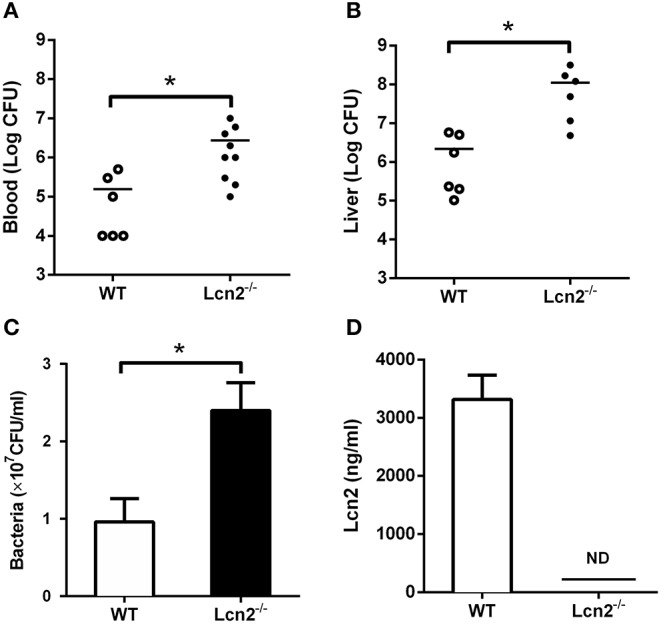
The bacteriostatic characteristics of lipocalin 2 (Lcn2). (A,B) Bacterial loads in blood (CFU/ml) and livers (CFU/mg) of E. coli O157:H7-infected mice 32 hpi. (C,D) Serum levels of Lcn2 protein measured and growth of E. coli O157:H7 in RPMI with 20% acute-phase serum from wild-type (WT) or Lcn2−/− mice. Values are average means of triplicate experiments with two mice per genotype per experiment. Error bars depict SEM (n = 6 per group). Results are expressed as means ± SEM. P < 0.05 was considered statistically significant. *P < 0.05.